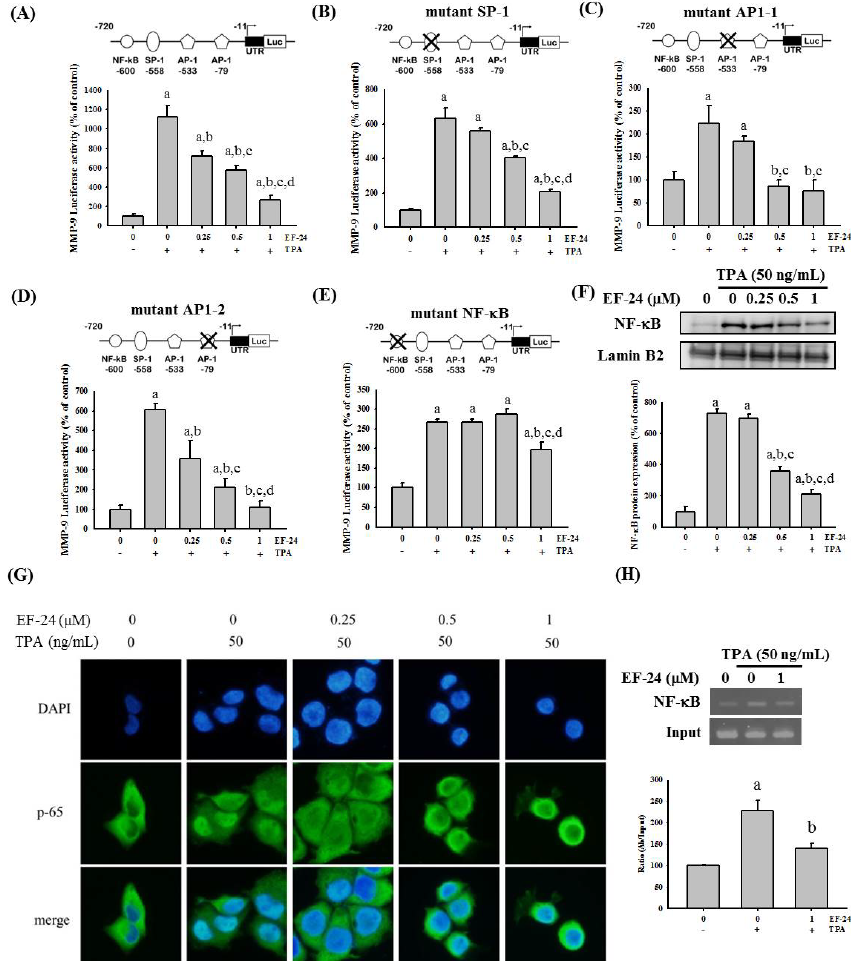
Figure 4. EF-24 suppresses MMP-9 gene transcription by interfering with nuclear translocation of NF- κ B. HONE-1 cells expressing a luciferase gene driven by wild-type ( A ) and various mutated forms ( B – E ) of MMP-9 promoter were pretreated with EF-24 for 1 h and then incubated with TPA for an additional 23 h. Luciferase assays were used to measure the transcriptional activity of MMP-9 promoter. Schematic representations of the reporter plasmids containing a mutated SP-1 ( B ), AP-1 ( C , D ), or NF- κ B responsive element ( E ) are shown on the top. To explore the nuclear translocation of NF- κ B, a nuclear extract of untransfected HONE-1 cells after the treatment of EF-24 and TPA was isolated and analyzed for the protein levels of NF- κ B ( F ). Blots are representative of three independent experiments. Densitometric analyses were conducted by ImageJ, and quantitative results were normalized to the nuclear levels of an internal control, lamin B2. In addition, HONE-1 cells treated with EF-24 and TPA were fixed and stained with DAPI and a specific antibody against NF- κ B p65 ( G ). The interaction of NF- κ B with MMP-9 promoter was analyzed by using chromatin immunoprecipitation assay (ChIP) with an NF- κ B antibody in HONE-1 cells treated with or without NF-24 and TPA ( H ). Densitometric analyses were conducted by ImageJ. a Significantly different, p < 0.05, when compared with the control group. b Significantly different, p < 0.05, when compared with the TPA treatment group. c Significantly different, p < 0.05, when compared with the TPA treatment plus EF-24 (0.25 µ M) group. d Significantly different, p < 0.05, when compared with the TPA treatment plus EF-24 (0.5 µ M)